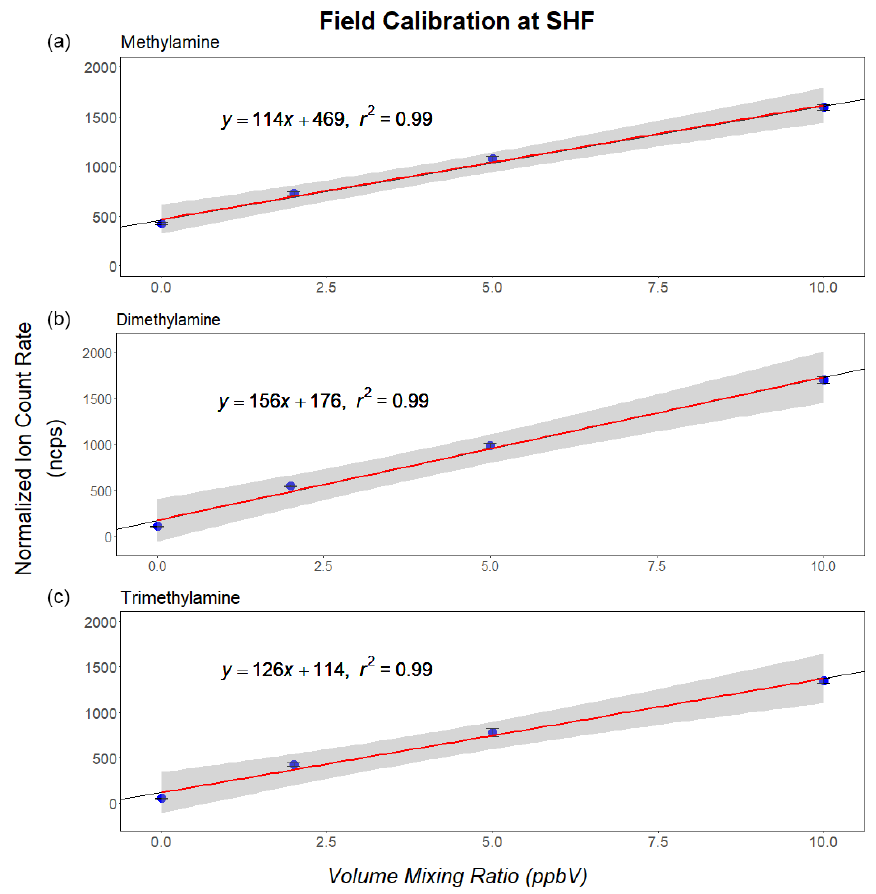
Figure 3. Calibration curves for methylamine (a) , dimethylamine (b) and trimethylamine (c) . The PTR-ToF-MS instrument was operated in the NH + mode (see text). 4